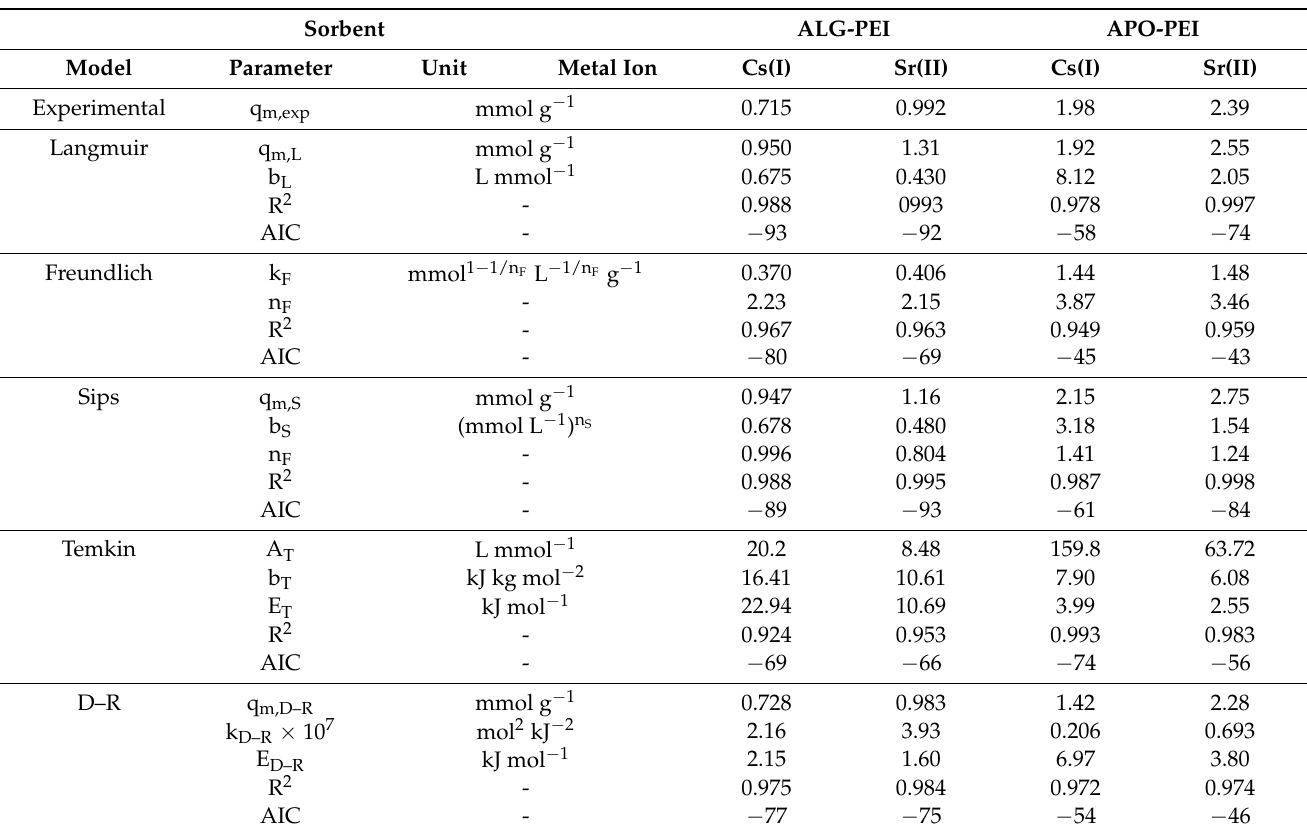
Table 2. Cs(I) and Sr(II) sorption isotherms using ALG-PEI and APO-PEI sorbents: parameters of the